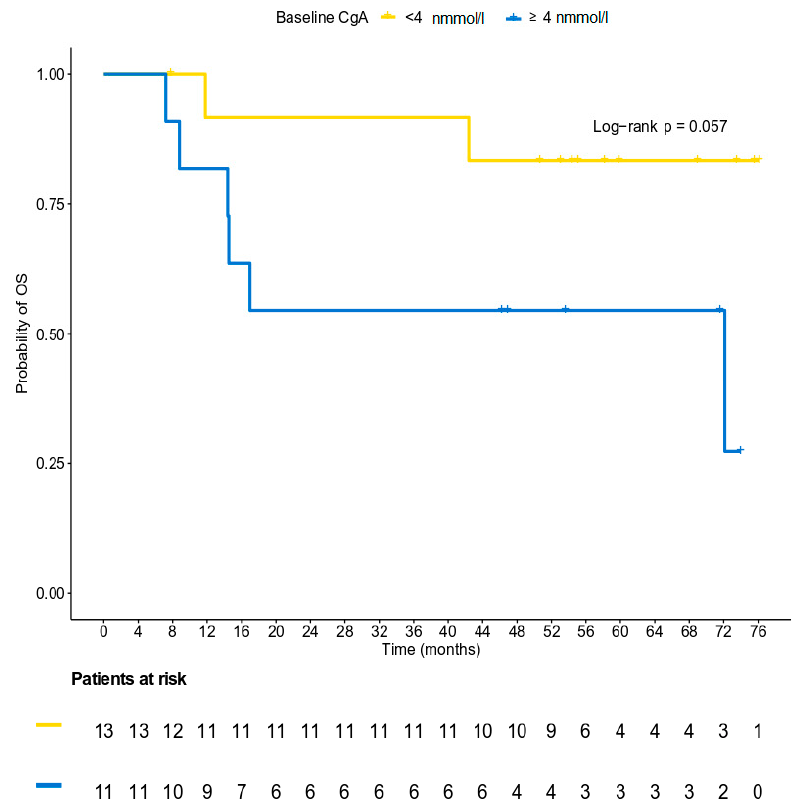
Figure 6. A Kaplan-Meier plot with respect to OS based on the status of chromogranin levels at